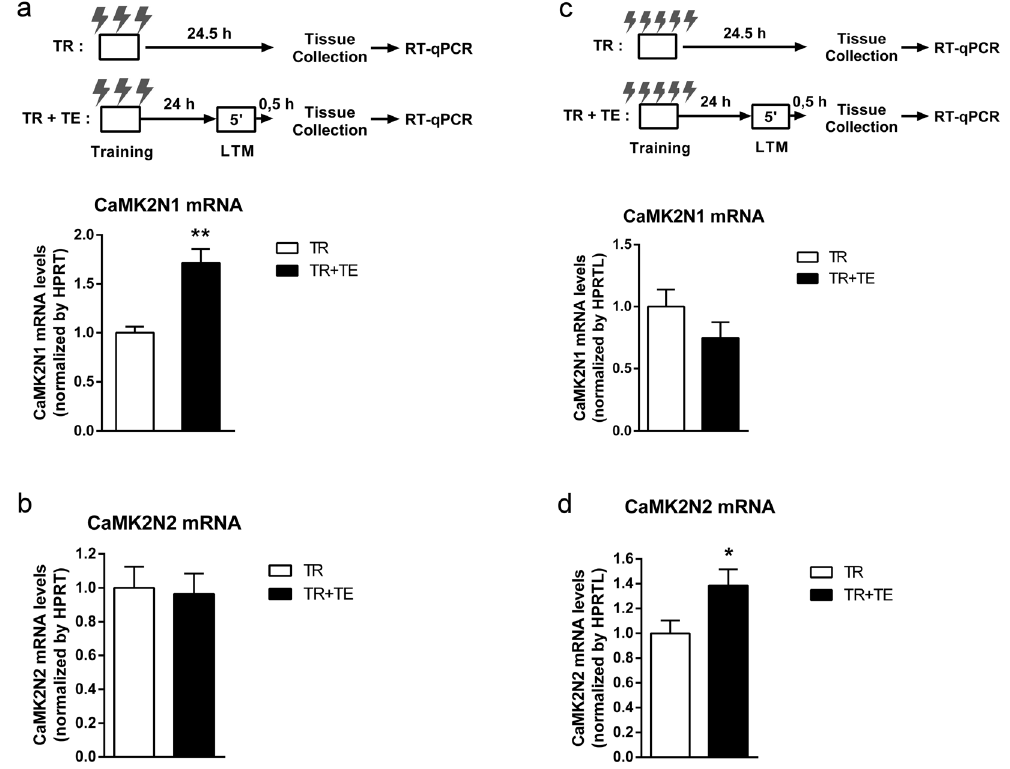
Figure 2. Effect of contextual fear memory retrieval on CaMK2N1 and CaMK2N2 dorsal hippocampi mRNA levels. ( a ) Animals (n = 10) were conditioned with 3 foot shocks (0.7 mA, 2 s). Half of the conditioned animals retrieved contextual fear LTM for 5 minutes 24 hours after conditioning (TR + TE). All animals were sacrificed 24.5 h after conditioning and mRNA expression in dorsal hippocampi was studied using RT-qPCR analysis. Retrieval of contextual fear LTM significantly upregulated CaMK2N1 expression. ( b ) CaMK2N2 mRNA levels were not altered by reactivation of contextual fear LTM. ( c ) A different cohort of animals (n = 12) was conditioned with 5 foot shocks (0.7 mA, 2 s) and, as in panel ( a ), half of the animals retrieved contextual fear LTM. CaMK2N1 expression did not change by retireval of this stronger contextual fear LTM. ( d ) However, CaMK2N2 mRNA levels were significantly increased by LTM retrieval. Hence, the intensity of the unconditioned stimulus influences the effect that memory retrieval has on the expression of the two endogenous CaMKII inhibitors. Mean and S.E.M.; * P < 0.05; ** P <